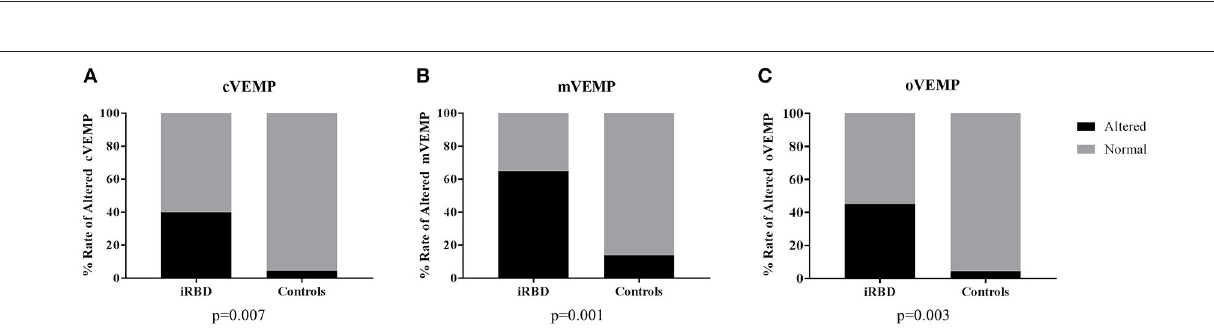
FIGURE 1 | Cervical (cVEMP), masseter (mVEMP) and ocular (oVEMP) VEMPs from sternocleidomastoid (SCM), masseter (MM) and inferior oblique (IOM) muscles in controls and RBD. In patients, oVEMPs and cVEMPs are absent and amplitude of mVEMP is reduced. Arrows: time of stimulus delivery.